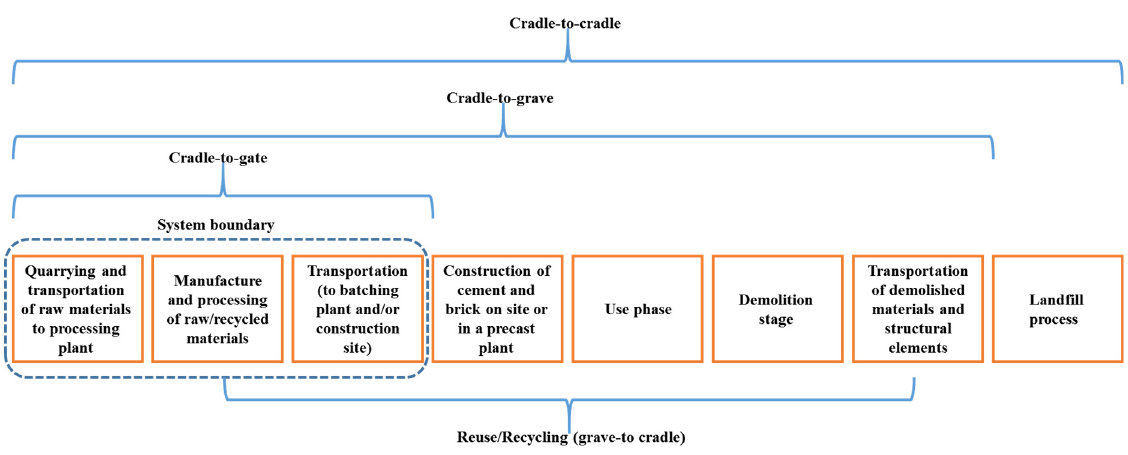
Figure 7. Process-based LCA method [41–44].